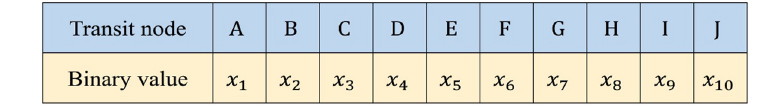
Figure 3a. Particle-represented arrangement of transit stations in the existing transportation network